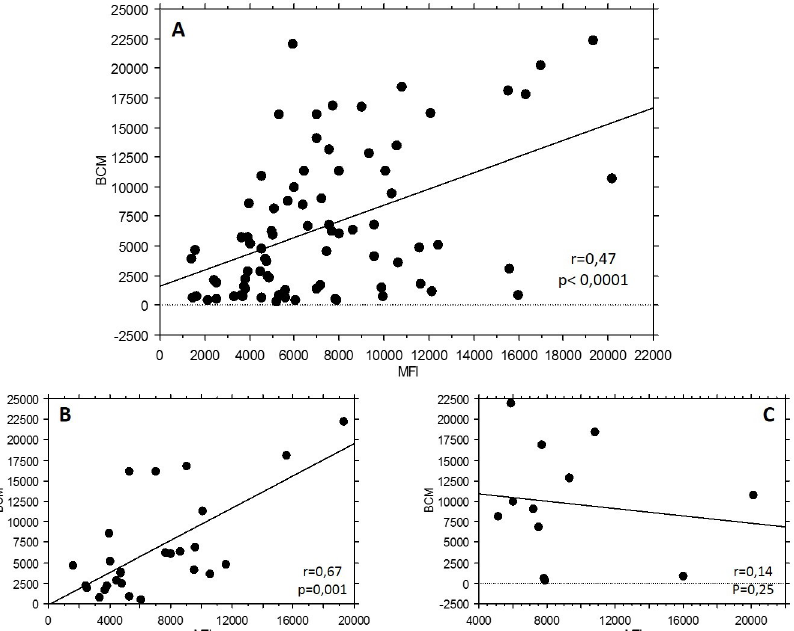
Fig 1. A. Correlation between BCM (Immucor Lifecodes SAB) and MFI (One Lambda Labscreen SAB) of iDSA, in the subgroup of 80 patients tested positive for the same iDSA. B. Correlation between BCM (Immucor Lifecodes SAB) and MFI (One Lambda Labscreen SAB) for anti DQ2 specificity. C. Correlation between BCM (Immucor Lifecodes SAB) and MFI (One Lambda Labscreen SAB) for anti DQ7 specificity. iDSA: immunodominant; MFI: mean fluorescence intensity; SAB: single antigen